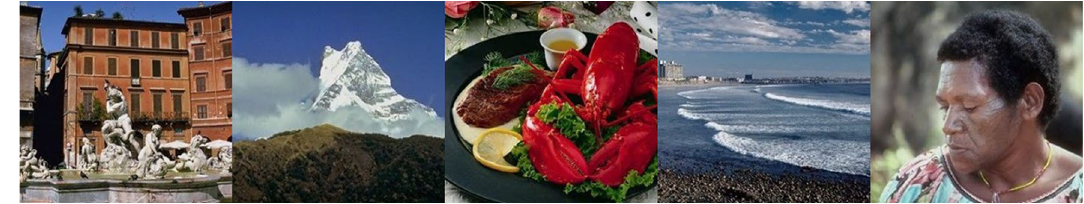
using deep learning. Autocorrelation, image gradient, Gaus-